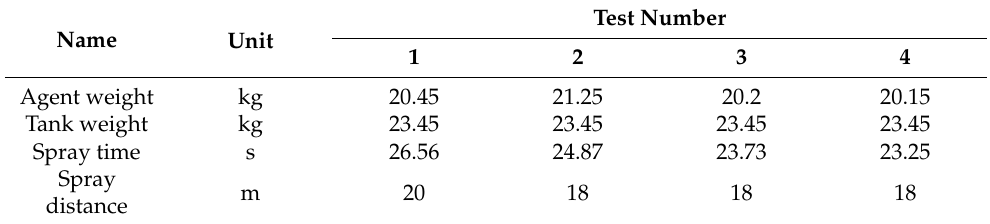
Table 4. Experiment results of spraying dry powder of the pressure fire extinguishing